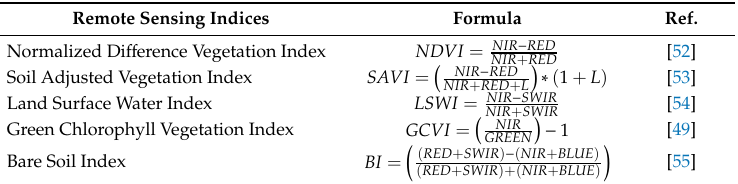
Table 2. Remote sensing derived indices used in this study.